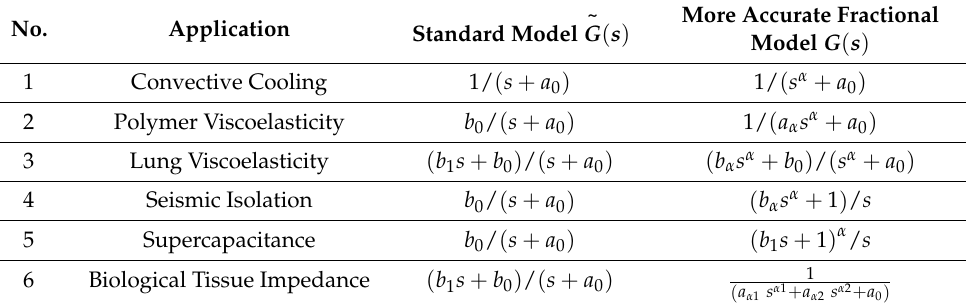
Table 1. Fractional Transfer Functions in Practical Applications